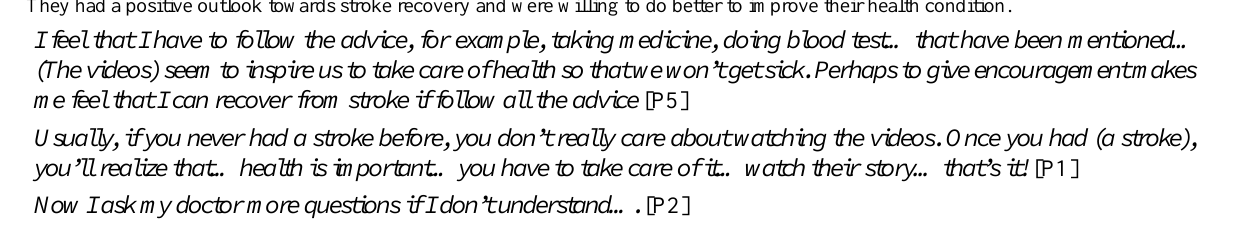
Table 2. Outcome measurement of both groups at baseline (T0 a ) and posttest (T1 b ) assessments.